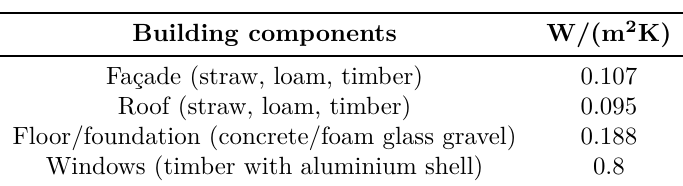
Table 1. Thermal performance of the building [12, 14,